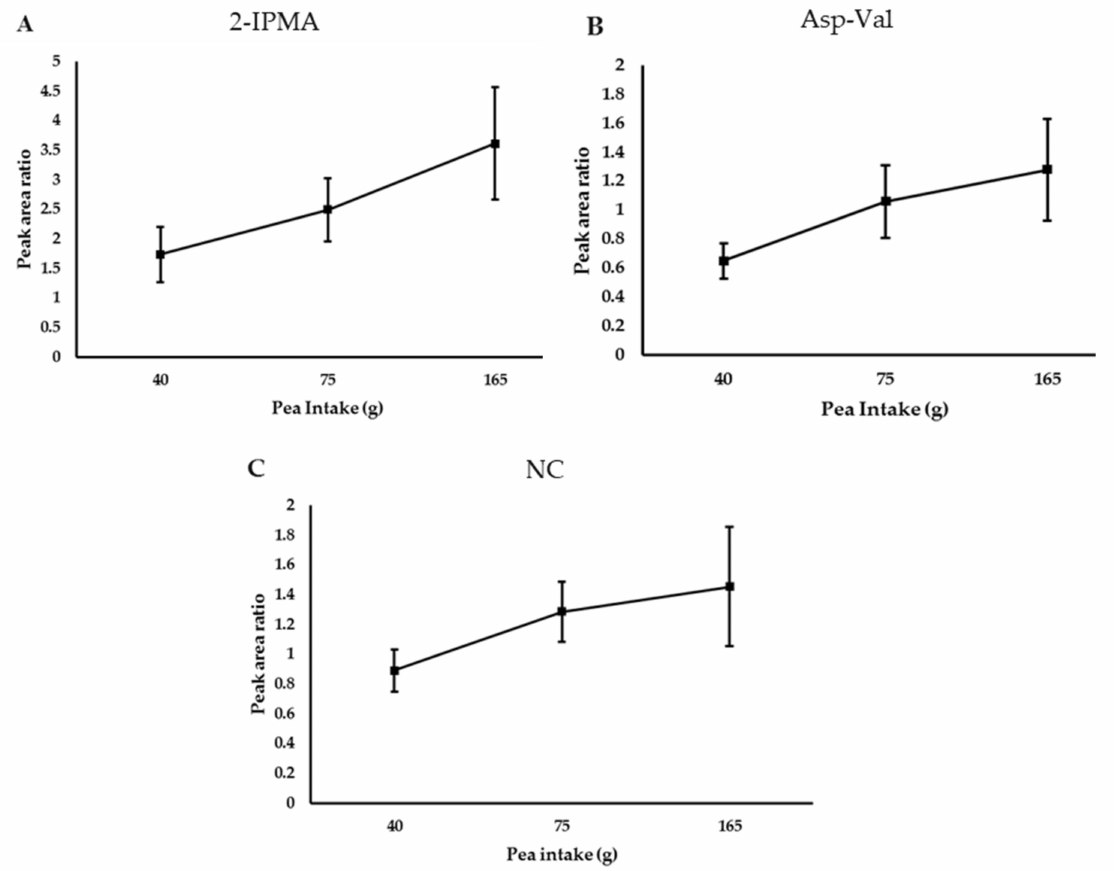
Figure 5. Urinary 2-Isopropylmalic acid (2-IPMA) ( A ); Asparaginyl valine (Asp-Val) ( B ); and N-Carbamoyl-2-amino-2-(4-hydroxyphenyl) acetic acid (NC) ( C ) demonstrated a dose–response to intake of peas from the dose–response study. Values are means ± SEMs ( n = 12). Participants consumed a low (40 g) (L), medium (75 g) or high (165 g) portion of peas as part of their habitual diet for four consecutive days for each intervention week and first void urine sample collected on the fifth day was analysed. X-axis values represent pea intake (g); Y-axis values represent peak area ratio. Peak area ratio is obtained by dividing the peak area of the sample with that of the internal